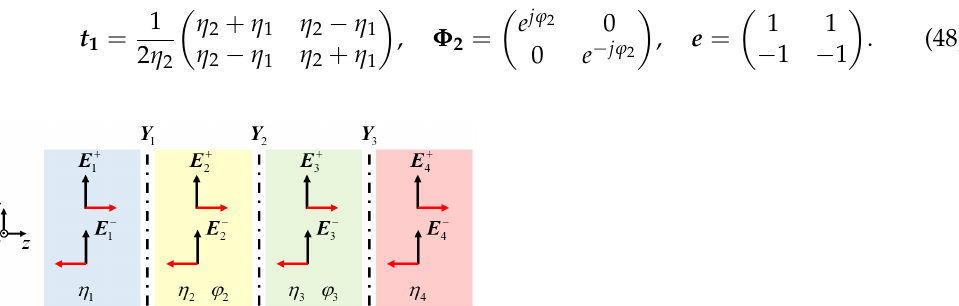
Figure 11. A cascaded metasurface structure consists of three sheets with only electric responses ( γ = χ = Z = 0